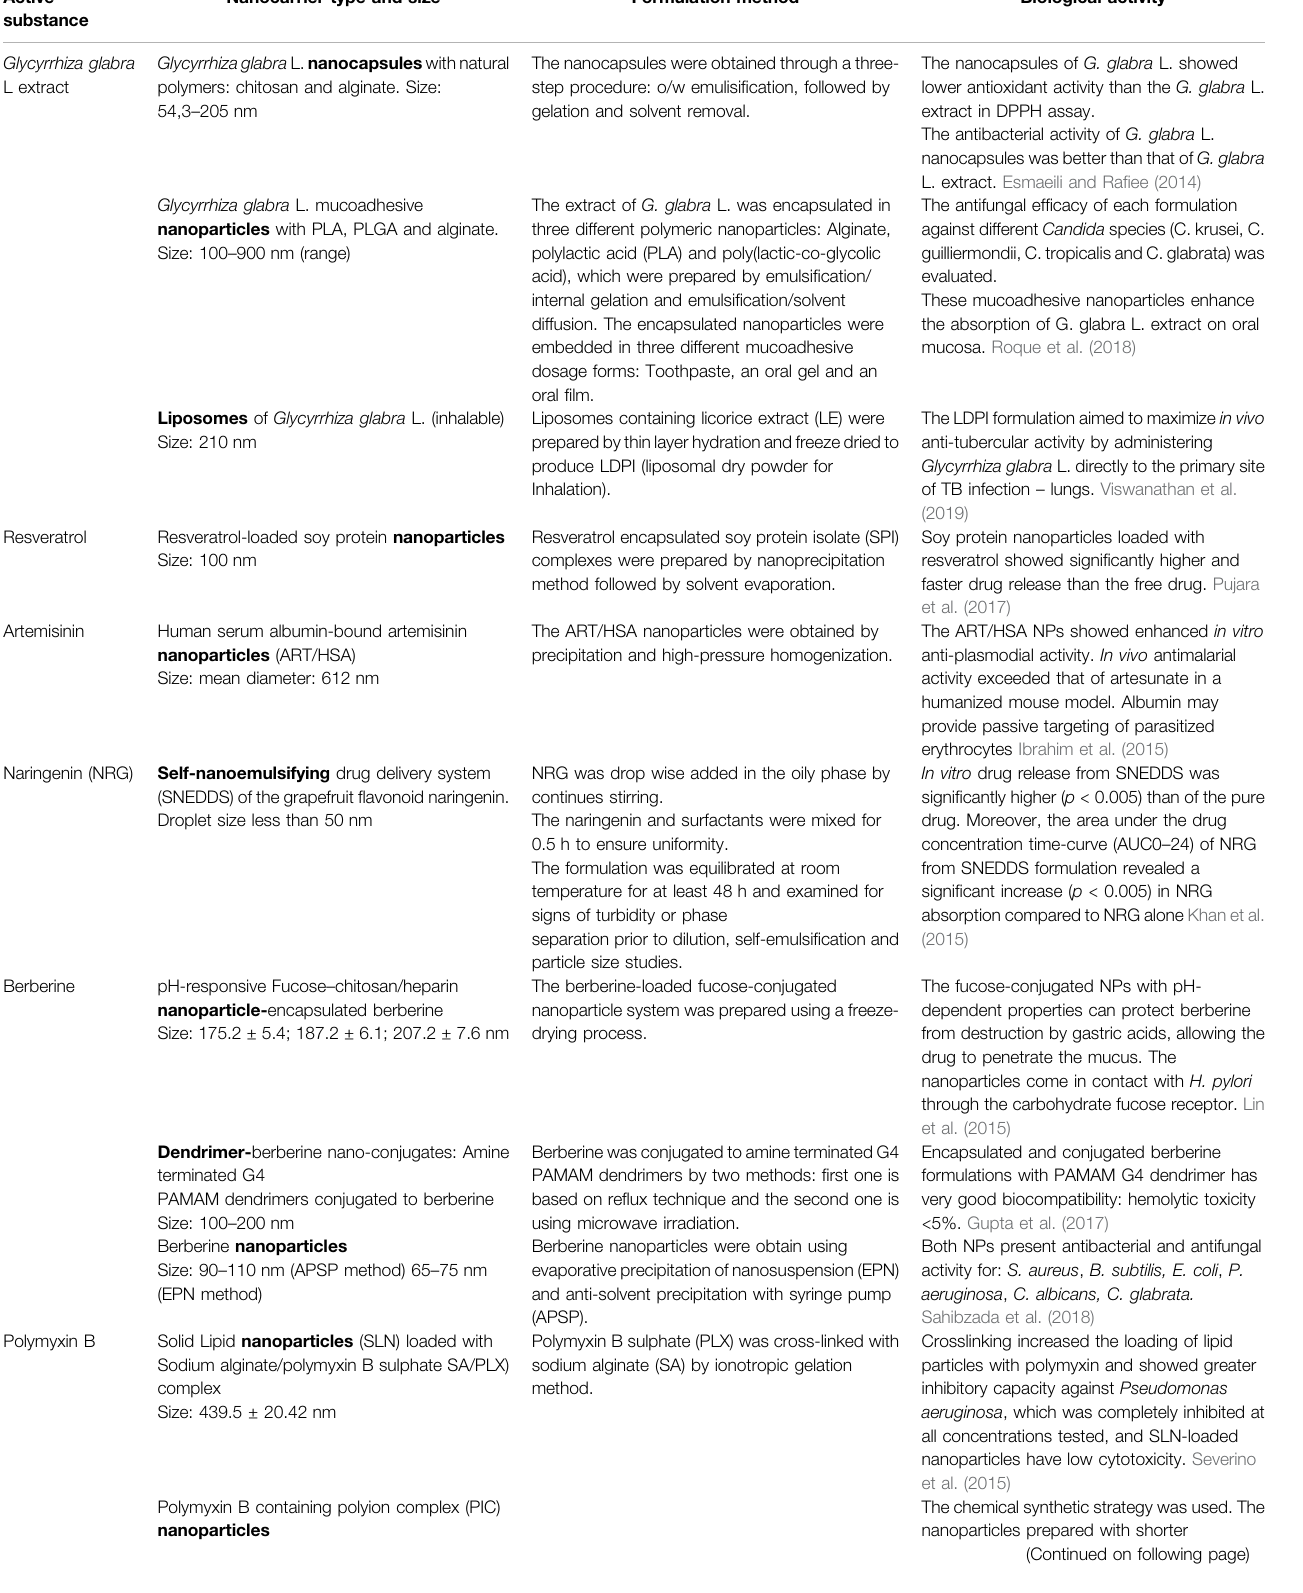
TABLE 6 | Active substances and nanocarriers used for their enhancement and